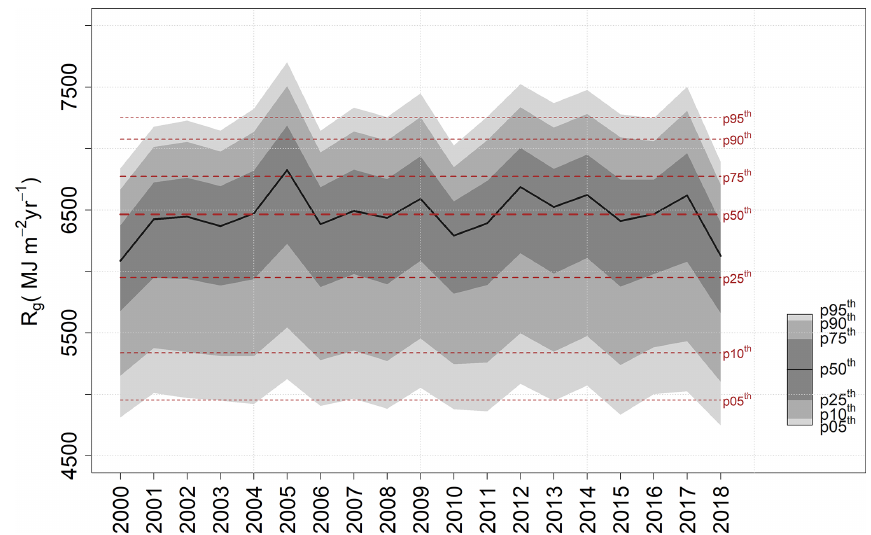
Figure 13. Evolution of the statistical distribution of annual R g (MJm − 2 yr − 1 ) in the study period (2001–2018) throughout the study area. Dashed lines represent the mean values of the percentiles